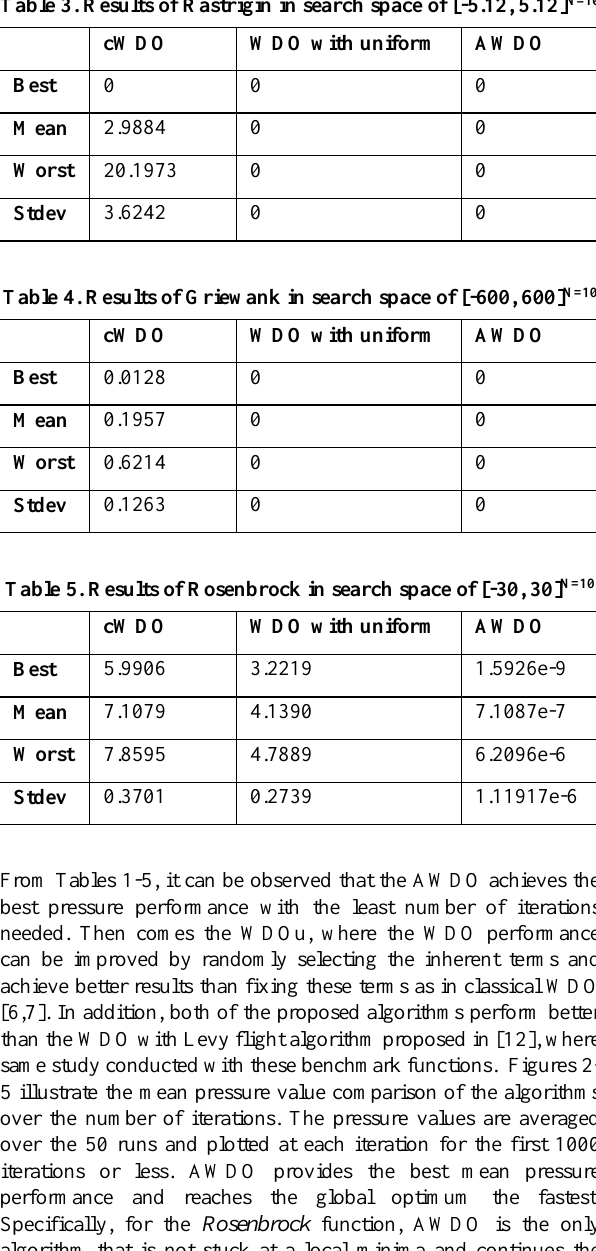
Table 3. Results of Rastrigin in search space of [-5.12, 5.12] N=10